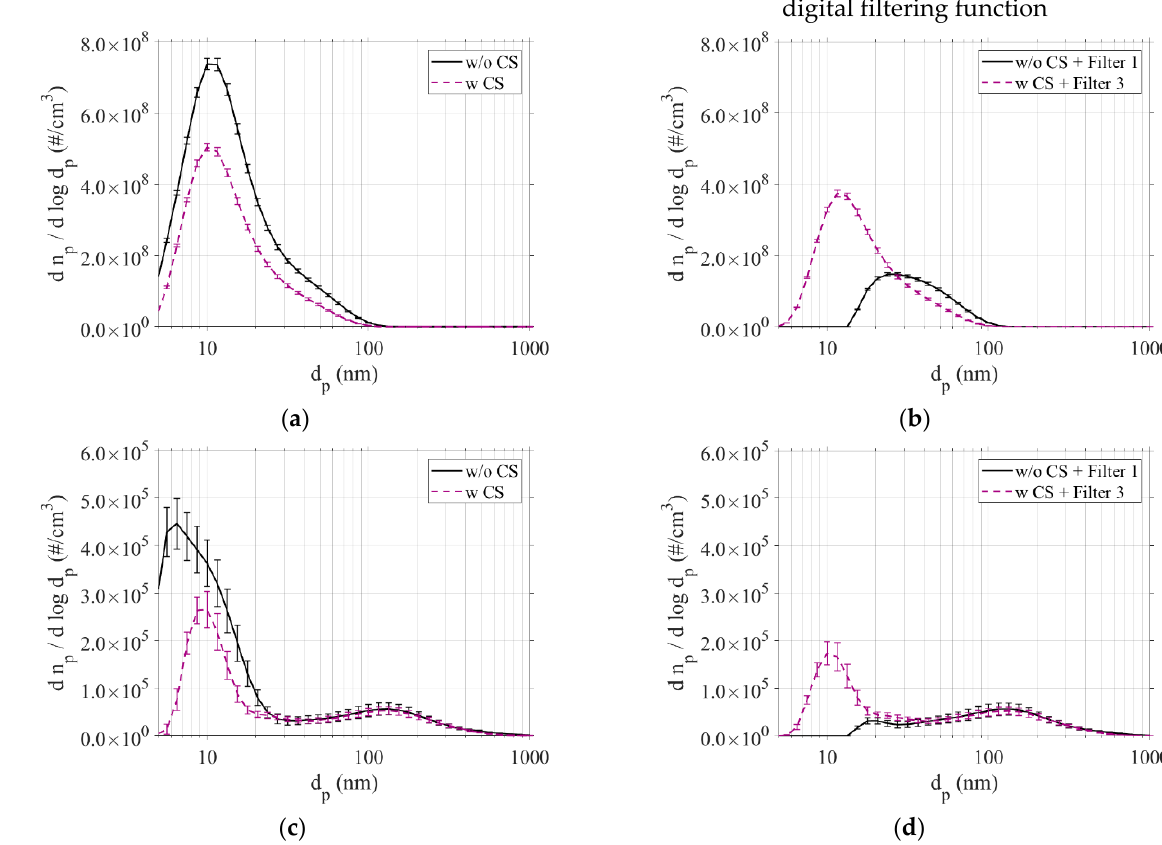
Figure 4. Particle size distributions (PSDs) for DMS measurements with and without catalytic stripper (CS), for fast-idle operation at 1250 rpm ( a , b ) and 40 Nm at 2250 rpm ( c , d ). The PSDs in subfigures ( a , c ) have been particle loss corrected. The PSDs in subfigures ( b , d ) have been digitally filtered in addition to the particle loss correction. For the digital filtering, Equation (1) was applied for Filter 1 (i.e., F1-PN > 23) and Equation (3) for Filter 3 (i.e., F3-PN > 10). Error bars indicate 95% confidence